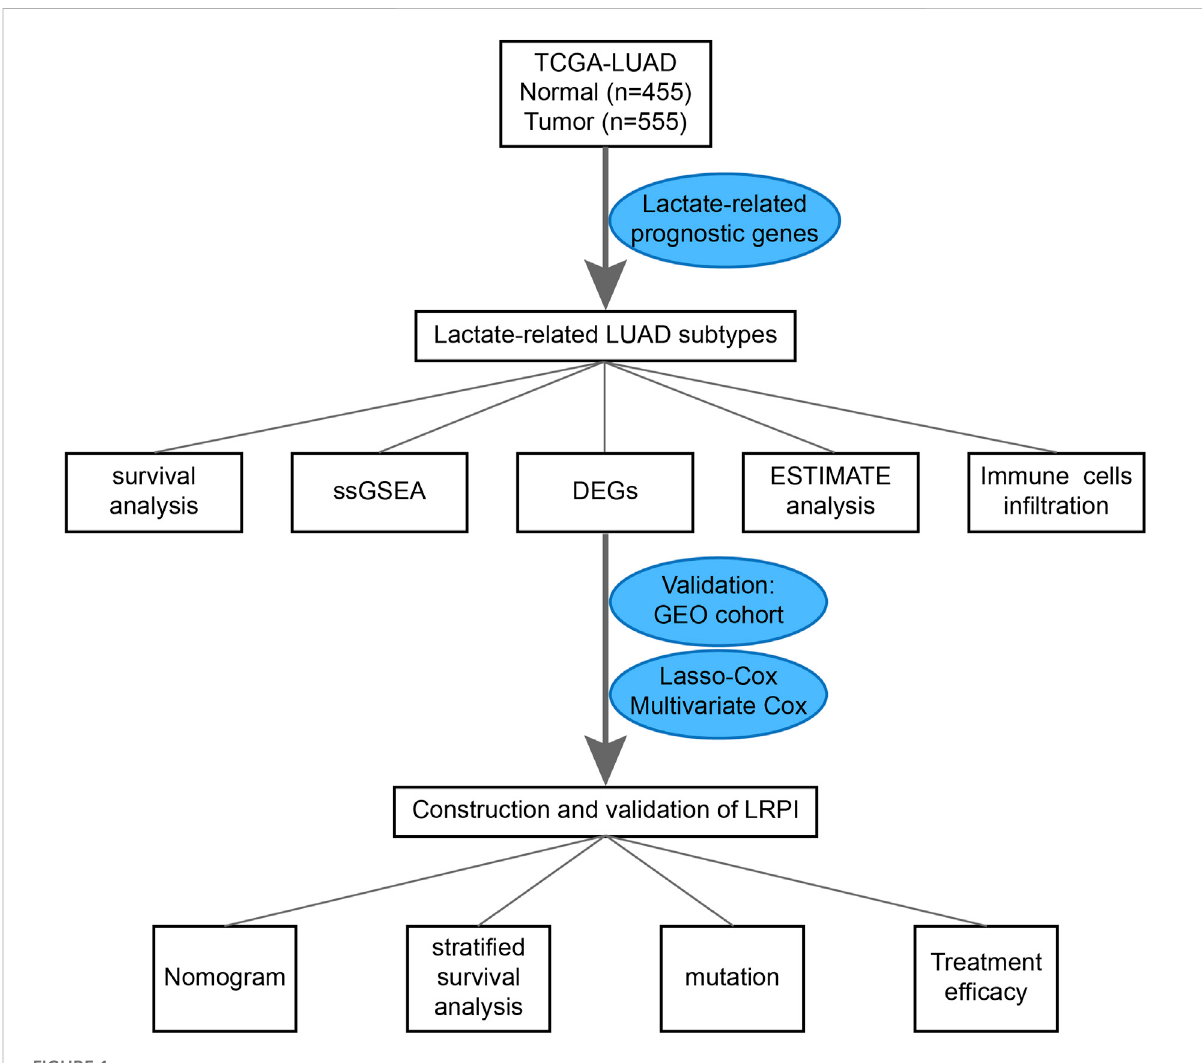
FIGURE 1 The fl owchart showed the design of the